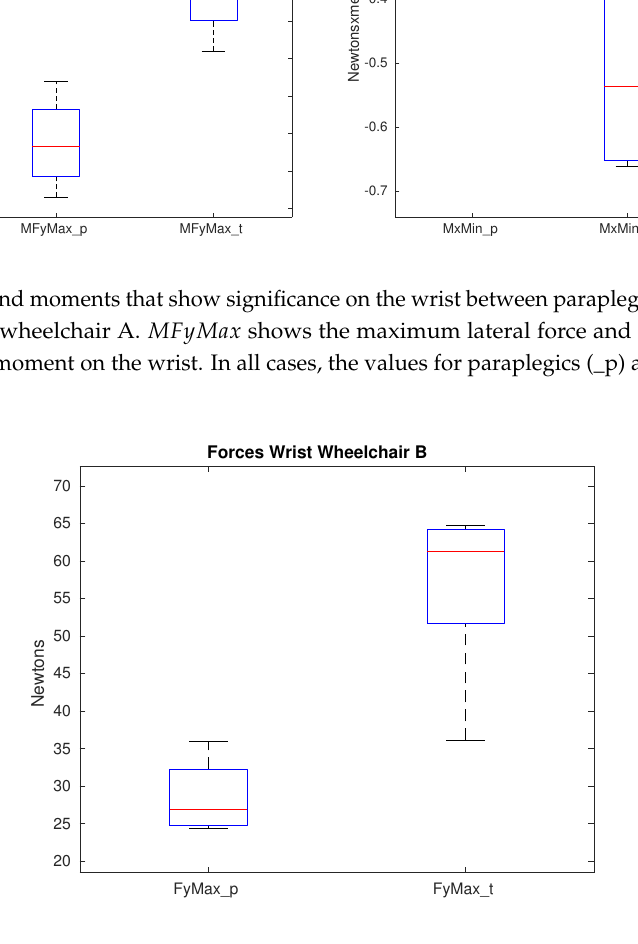
Figure 10. Maximum lateral force that shows significance on the wrist between paraplegics and tetraplegics when propelling wheelchair B. Values for paraplegics (_p) and tetraplegics (_t) are shown. Table 13. Kinematic variables on the wrist: maximum, minimum and ROM values (mean ± SD) and the propulsion phase in which they happen: pushing (p) or recovery phase